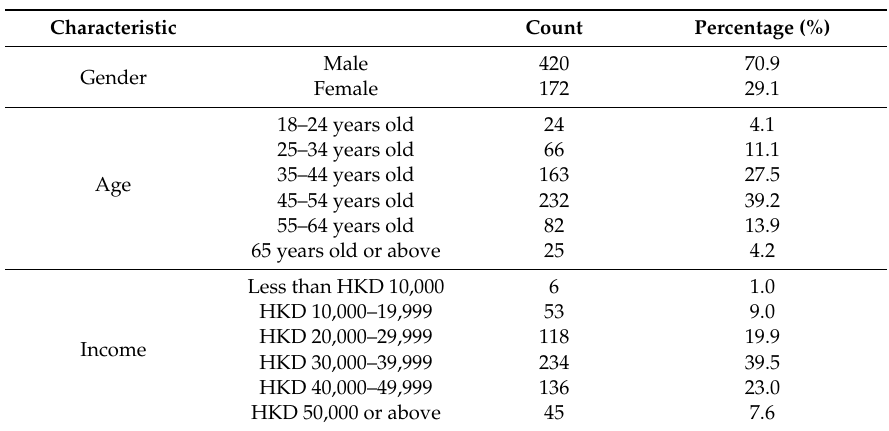
Table 2. Profile of the valid respondents of the survey ( n =